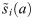
Comparing selections of libraries built on scaffolds with different degrees of maturation.A. Parameters (μ, σ) of the distributions of enrichments for our 3 libraries selected against 4 targets. The color of the symbols indicates the library (Germ, Lim or Bnab) and its shape the target (DNA1, DNA2, prot1 or prot2) with the conventions defined in B. Symbols with a black or no contour indicate results from replicate experiments where the 3 libraries are mixed in the initial population. μGerm,T is conventionally set to μGerm,T = 0 for all targets T (Methods). μ is generally more challenging to infer than σ and it shows here more variations across replicate experiments. B. Sequence logos for s˜i(a), which represent the contribution of the different amino acids to the enrichments (see Box), for the selections of the three libraries, Germ, Lim and Bnab against the two DNA targets (DNA1 and DNA2) and the two protein targets (prot1 and prot2). These results correspond to the experiments of Fig 1 where the 3 libraries are mixed in the initial population. The Lim library is outcompeted by the other two libraries when selected against the DNA1 target, which does not leave enough sequences to make a meaningful inference (see also S10 Fig for more details on the sequence logos for the Bnab library). C. Sequence logos for s˜i(a) for the Germ and Lim libraries selected in isolation against the DNA1 target. For the Lim library, this palliates the absence of data in B. For the Germ library, it shows that the same motif with x1 = R, x3 = R or K and x4 = H dominates whether the library is selected in a mixture as in B or on its own; the area under the logos is, however, different: it would be σ2/2 with infinite sampling, but major deviations are caused by limited sampling (S9 Fig).